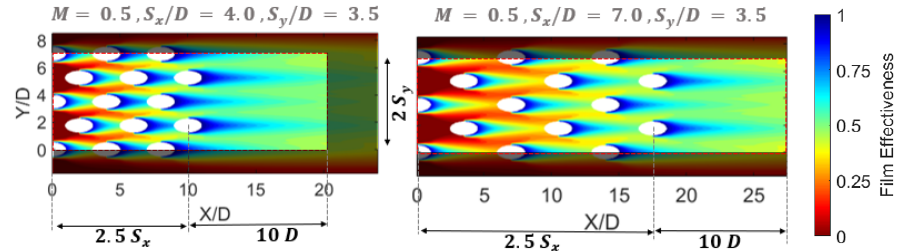
Figure 4. Comparison area for the mean film effectiveness with varying S x / D and S y / D , using a constant blowing ratio. Enhanced superposition occurs with reduced streamwise spacing.